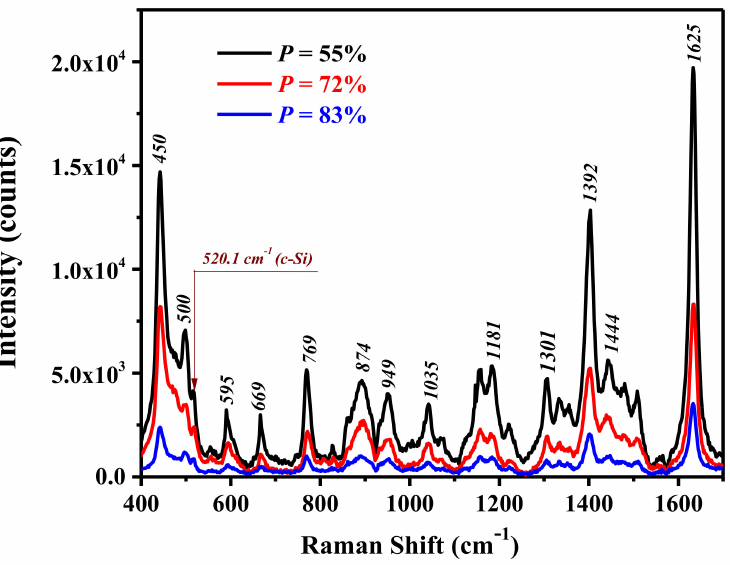
Figure 7. SERS spectra of SiNWs:Au-NPs samples with different porosity P after adsorption of 10 − 6 M of MB